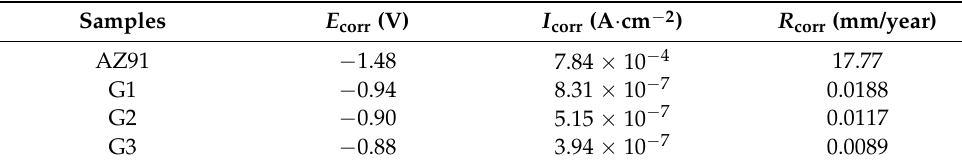
Figure 4. The results of electrochemical test ( a ) potentiodynamic polarization curves; ( b ) Nyquist plots; and ( c ) Bode plots of |Z| vs. frequency. Table 3. Potentio-dynamic polarization parameters of the